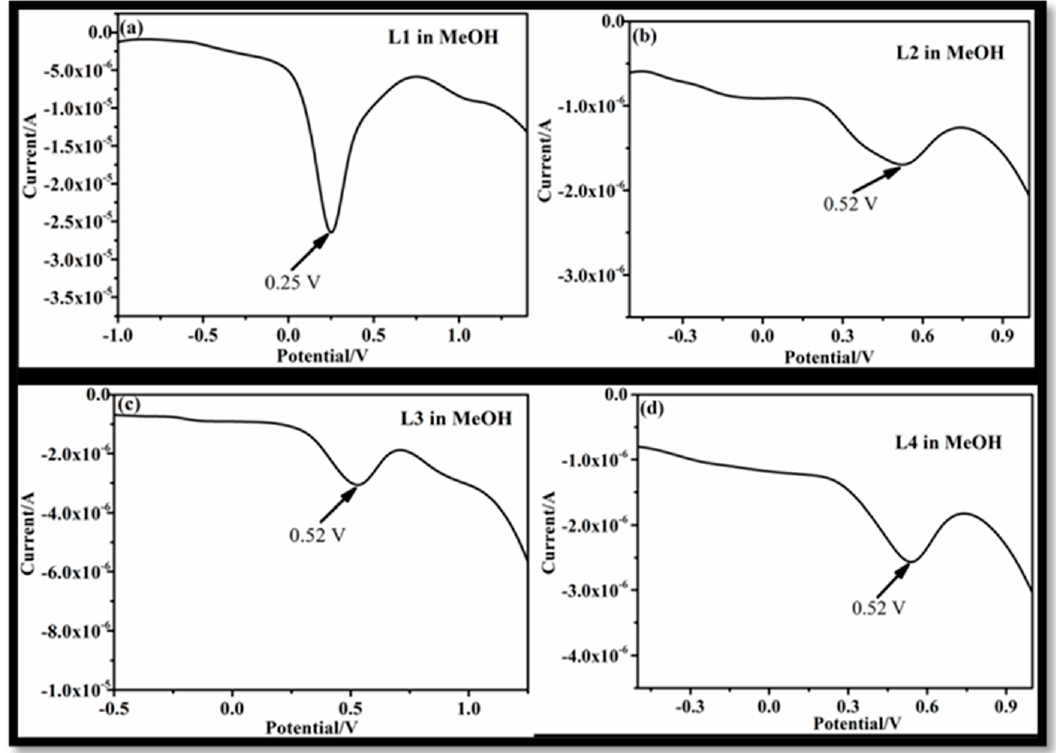
Figure 1. Anodic voltammogram of receptor L1 ( a ), L2 ( b ), L3 ( c ), and L4 ( d ) in MeCN medium.